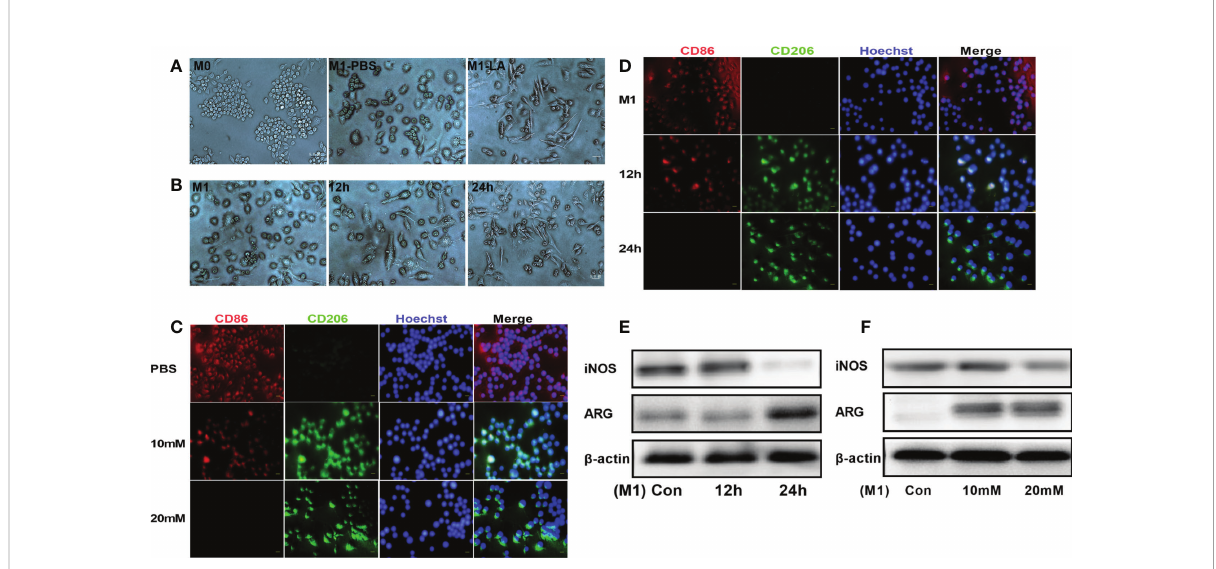
FIGURE 1 Lactate promoted M2 polarization of macrophages in vitro. (A) Representative images of macrophage phenotypes after lactate treatment. Polarization of macrophages toward the M2 phenotype was associated with elongated cell shape (n = 3). scale bar, 5 m m. (B) Morphological changes following the phenotypic transformation of macrophages at different time points (n = 3). scale bar, 5 m m. (C) Representative fl uorescence images showing the macrophage phenotypes after lactate treatment (n = 3). scale bar, 5 m m. (D) Representative fl uorescence images of macrophage phenotypes transformation after lactate treatment at different time points (n = 3). scale bar, 5 m m. (E) Western blotting assay showing the expression of phenotype-related markers in LPS-stimulated macrophages after lactate treatment at different time points (n = 3). (F) Expression level of M1 macrophages-related markers after a 24-h treatment with different concentrations of lactate as determined by western blotting (n =